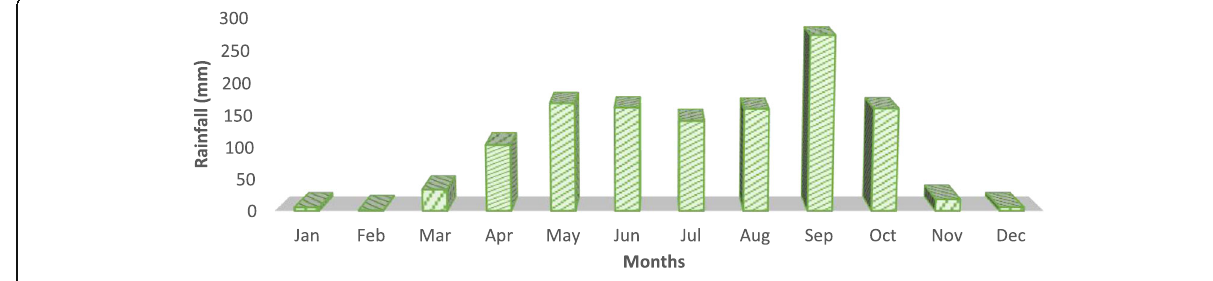
Fig. 5 Monthly amount of rainfall distribution in Ilorin,